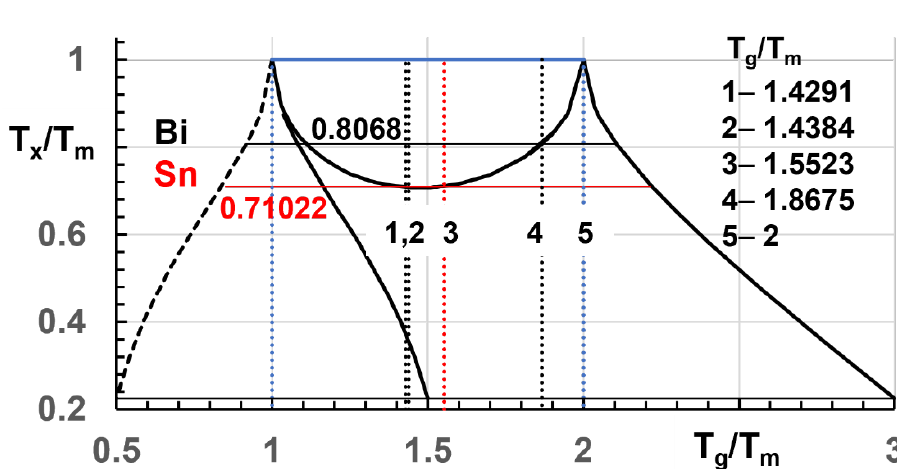
Figure 1. Glassy phase diagram ( T g /T m ) resulting from first-order transitions at T x /T m during heating of liquid elements. Valuable for all glass transitions due to Lindemann coefficients. For Bi, T x /T m = 0.8068 revealing T g /T m = 1.8675 as observed from differential thermal analysis (DTA). For Sn, T x /T m = 0.71022 reveals T g /T m = 1.5523. For T x /T m > 0.7069, there are five glass transitions. For T x /T m < 0.7069, the number of glass transitions is equal to 3. ( T g /T m ) can be higher than 2. Transitions at T g /T m = 1.4291 and 1.4384 are initiated by other ( T x /T m ) values. T g /T m = 0.5, 1.5 and 3 for T x /T m = 0.22451. For T x /T m = 1, transitions were observed at T g /T m with latent heat much weaker than ( Δε H m ) above T m .